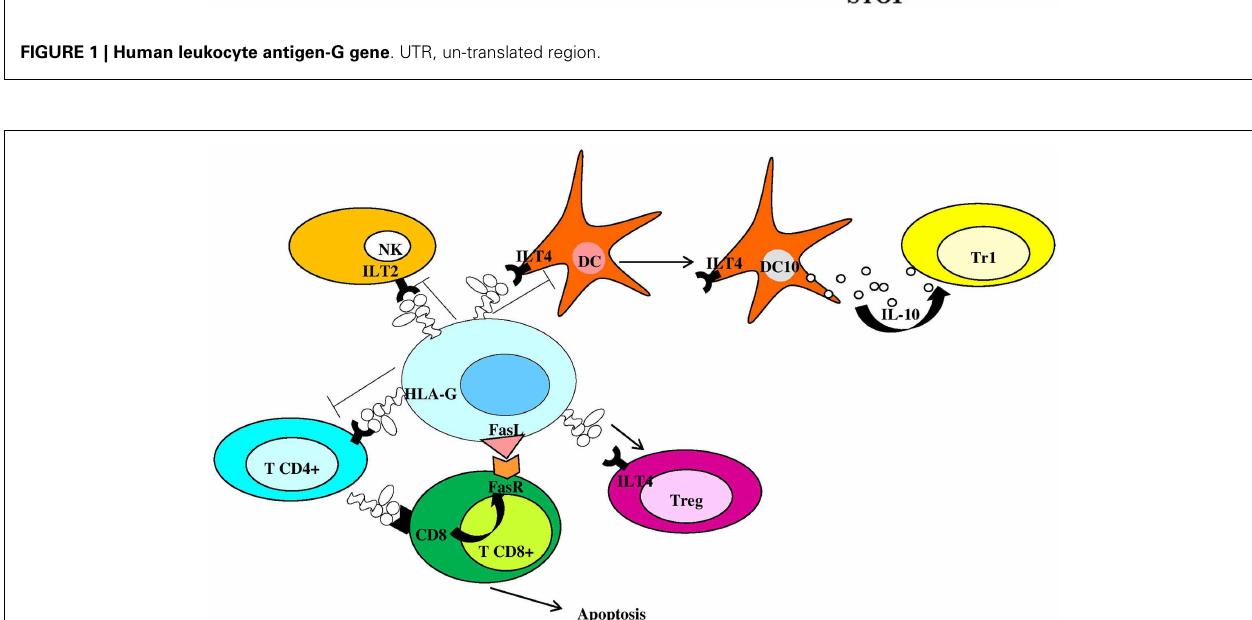
FIGURE 2 | Human leukocyte antigen-G is an anti-inflammatory molecule inhibiting and controlling immune cell activation . NK, natural killer cells;Tr1, type 1 regulatoryT cells; DC, dendritic cell;Treg, regulatoryT cell; FasR, Fas receptor; DC10, IL-10-differentiated dendritic